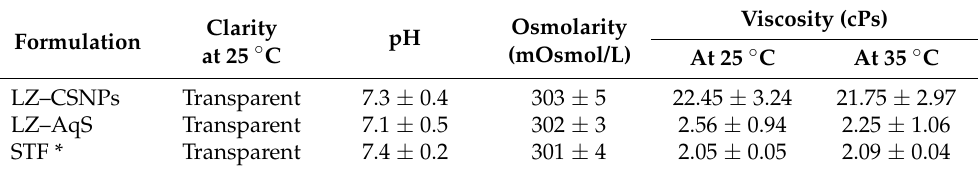
Table 1. Physicochemical characteristics of nanosuspension of LZ – containing formulations as com- pared to STF. Results were presented as the mean of three measurements with standard deviation (Mean ± SD, n = 3).